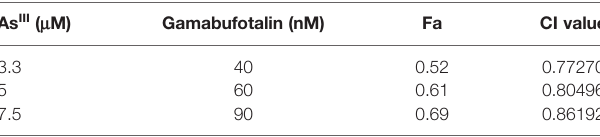
TABLE 1 | CI values of the combination of relatively high concentrations of As III and gamabufotalin in U-87 cells. As III ( m M)